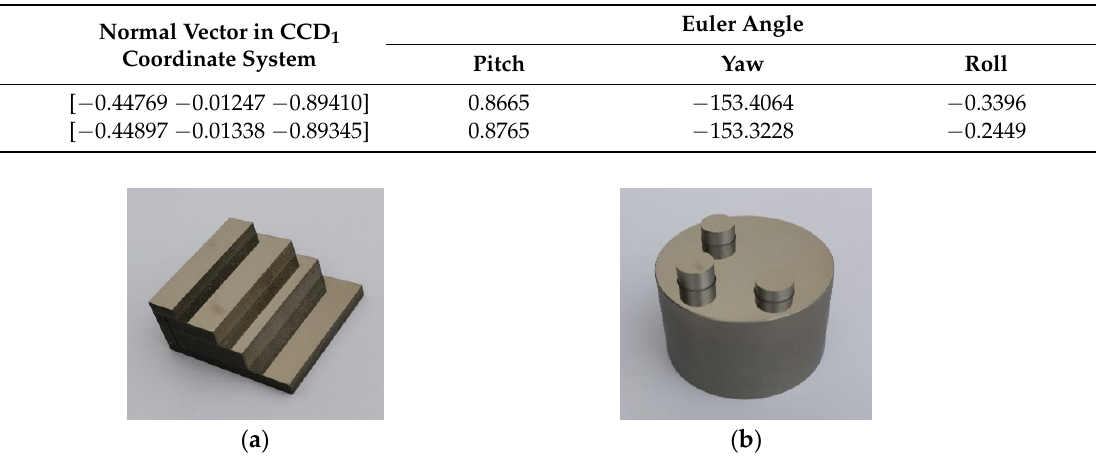
Figure 8. Two structured specular surfaces : ( a ) rectangular step; ( b ) circular step gauge.